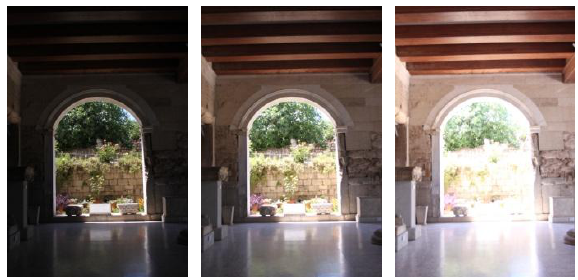
Figure 2: Bracketed exposure sequence of images from exposure -2EV to +2EV with exposure spacing